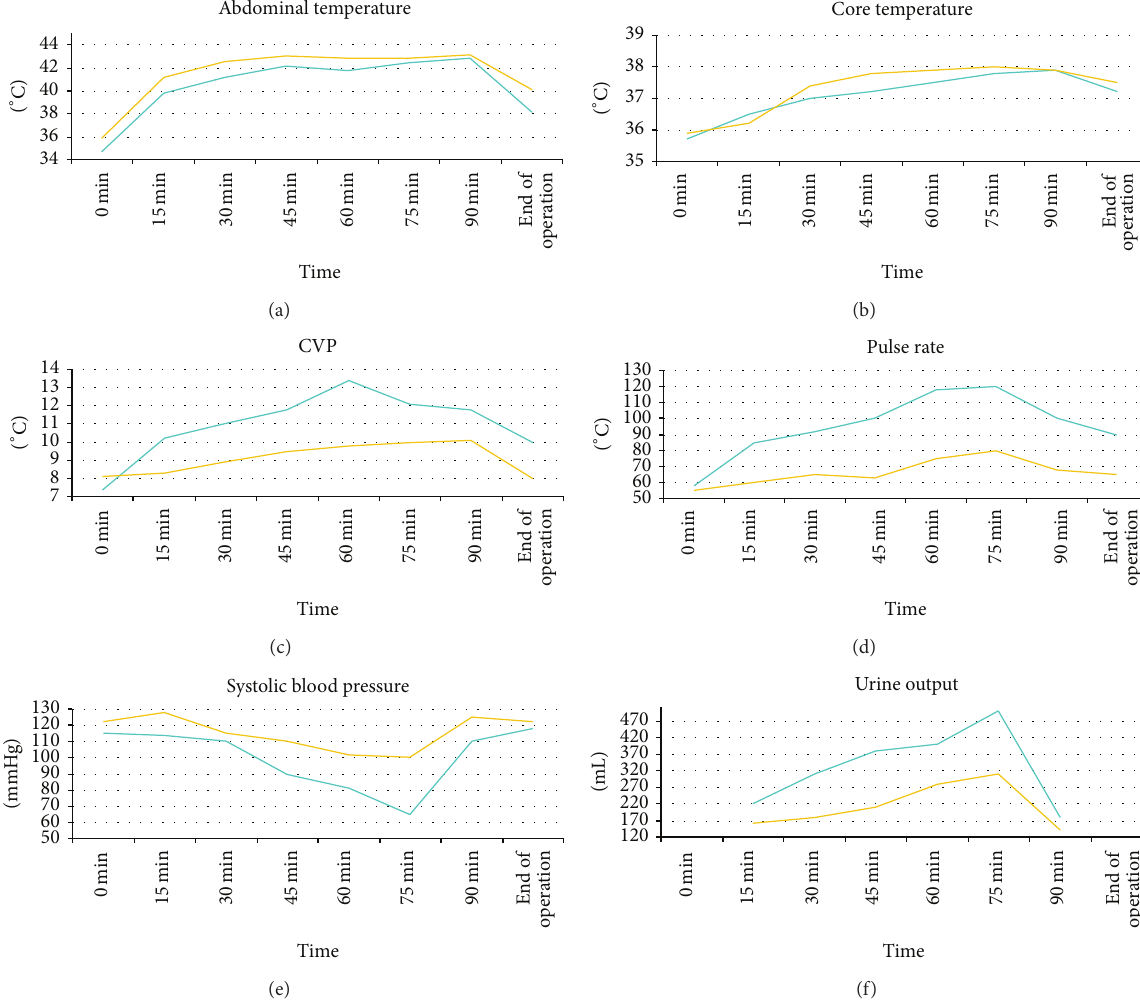
Figure 2: (a) Abdominal temperature. Blue = open, yellow = closed. (b) Core temperature. Blue = open, yellow = closed. (c) Central venous pressure. Blue = open, yellow = closed. (d) Heart rate. Blue = open, yellow = closed. (e) Systolic blood pressure. Blue = open, yellow = closed. (f) Urine output. Blue = open, yellow =